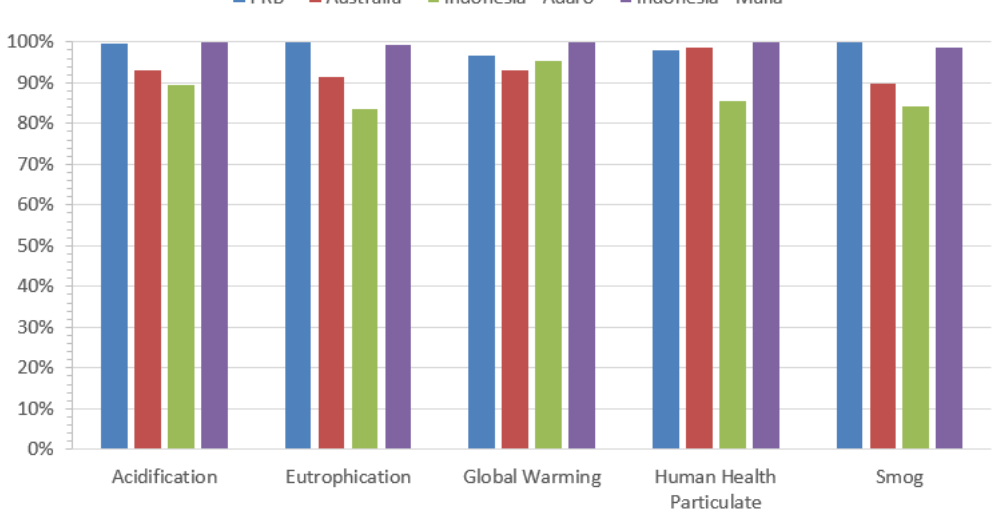
Figure 6. TRACI 2.1 impact assessment results for the Japan scenario with ocean transport impacts included. Results are normalized to highest contribution in each impact category. Global Warming values taken from previous section.